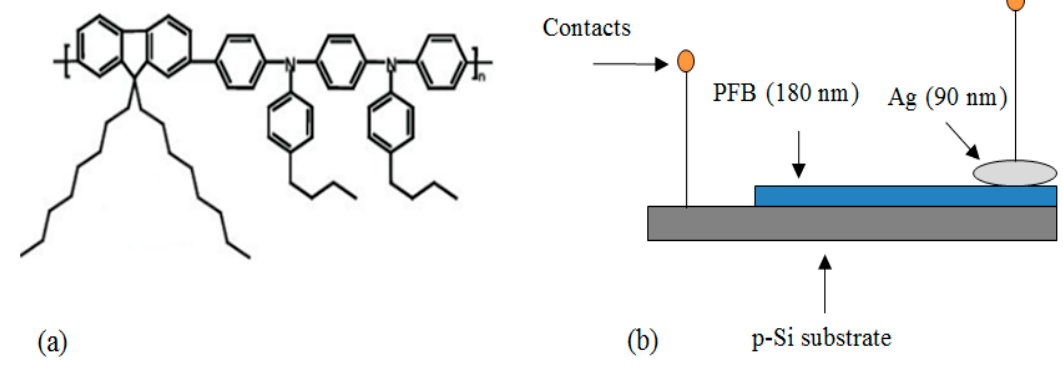
Figure 1. ( a ) Molecular structure of PFB and ( b ) schematic diagram of Ag/PFB/p-Si